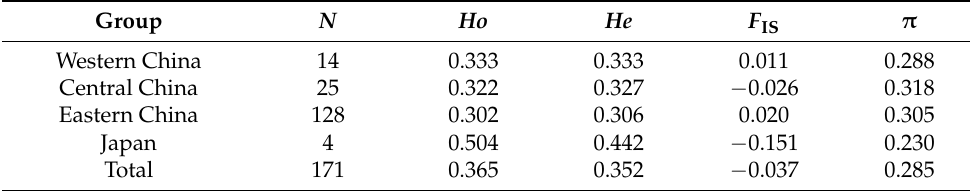
Figure 4. The principal coordinate analysis of C. camphora populations using all identified SNPs as markers. The populations from different geographic locations were coloured red (Central China), purple (Western China), blue (Eastern China), and green (Japan). Table 2. Diversity statistics of four C. camphora